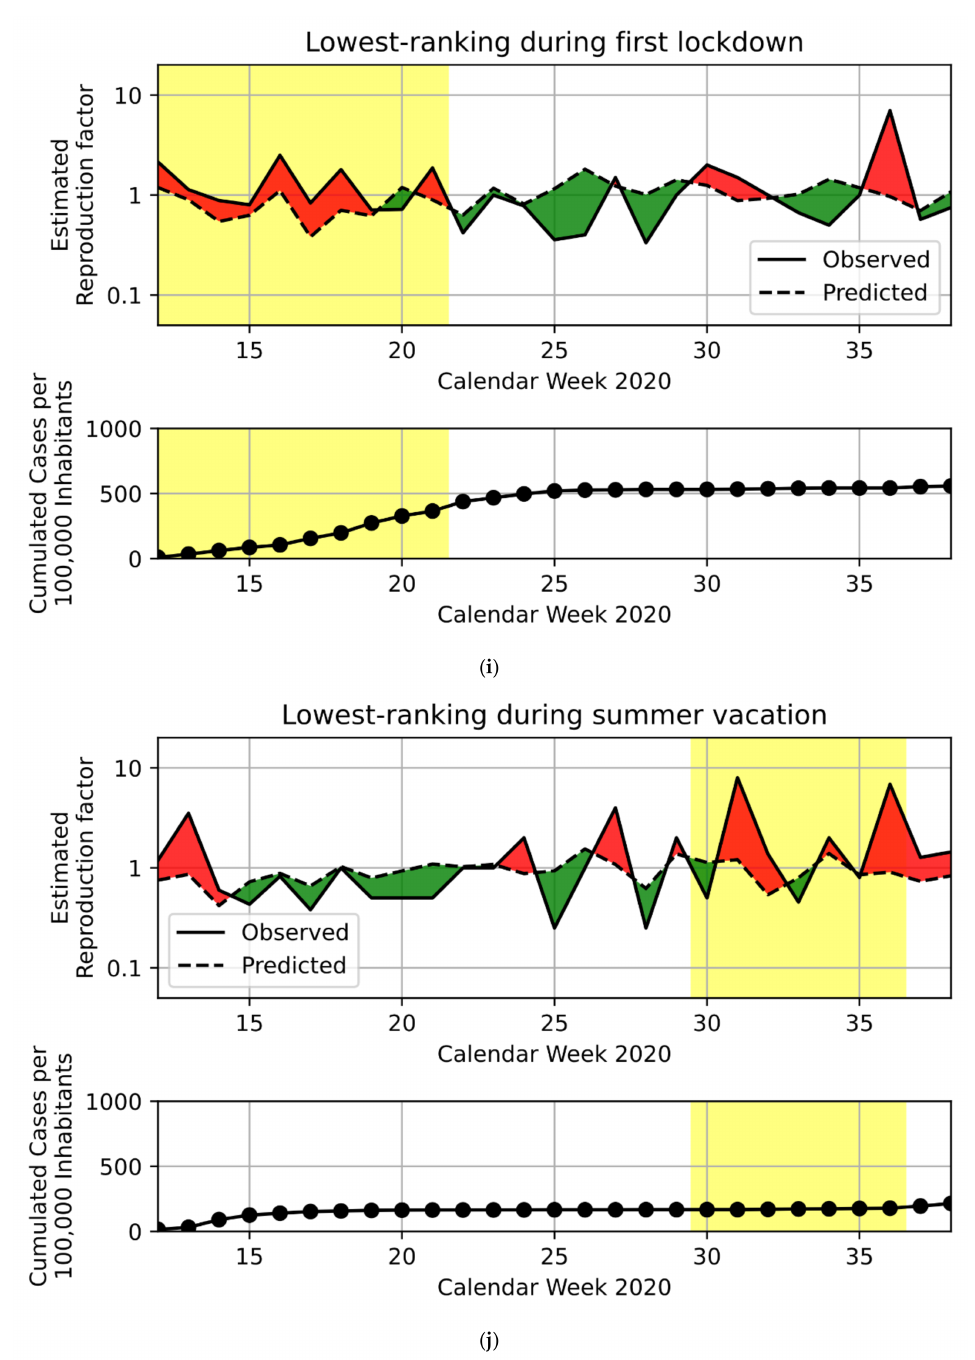
Figure 1. Reproduction rate and cumulated incidence of selected German districts. In descending ranking order, ( a – c ) show the identified PD candidate districts for the first lockdown, and ( d – f ) show those for the summer vacation period. For comparison, we also show each timeframe’s median ( g , h ) and lowest-ranking ( i , j ) districts. Yellow shading indicates the timeframe for which the district was identified as either PD candidate, or median/lowest-ranking comparison district. Upper sub-plots show both the predicted (dashed line) and observed (solid line) weekly reproduction factor on a log-scale. Green areas indicate positive deviance values where the observed values were lower than predicted. Red areas indicate negative deviance where the observed values exceeded the predictions. Since our model utilized log-R0 (cid:48) s, the red and green areas correspond to actual deviance values despite the log-scale axis. Lower sub-plots show cumulated case numbers per 100,000 inhabitants, included to visualize the relationship of forward transmission and case incidence. KS = ‘Kreisfreie Stadt’, i.e., the independent city districts explained in Section